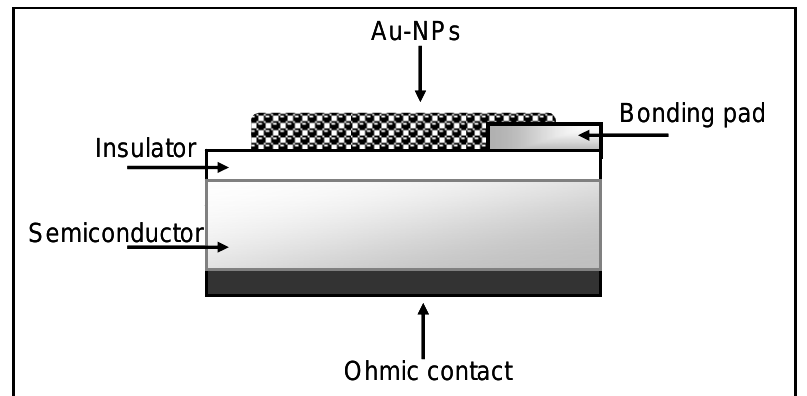
Figure 6. Schematic diagram of the Au-NPs FET